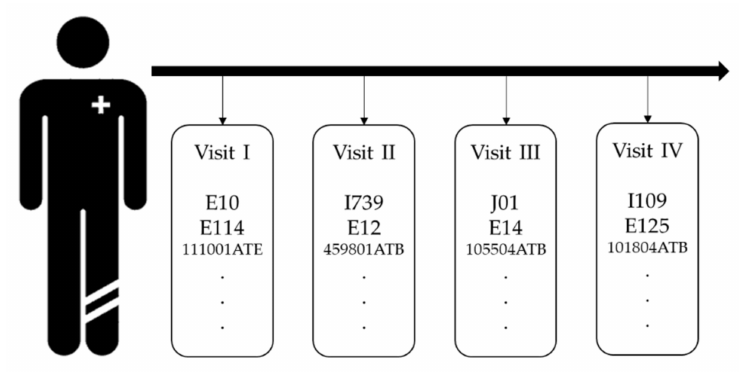
Figure 1. An Illustration of EHRs.